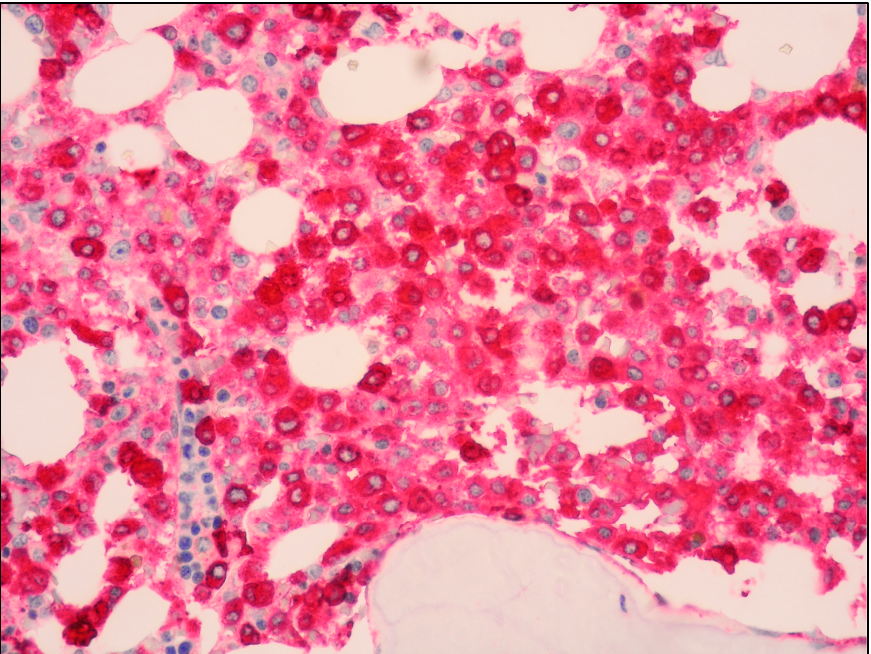
Figure 4. High-power view of BM infiltrate with diffuse and intense tryptase positivity (Tryptase immunostaining, magnification 400×; original image from Prof. S.A.).